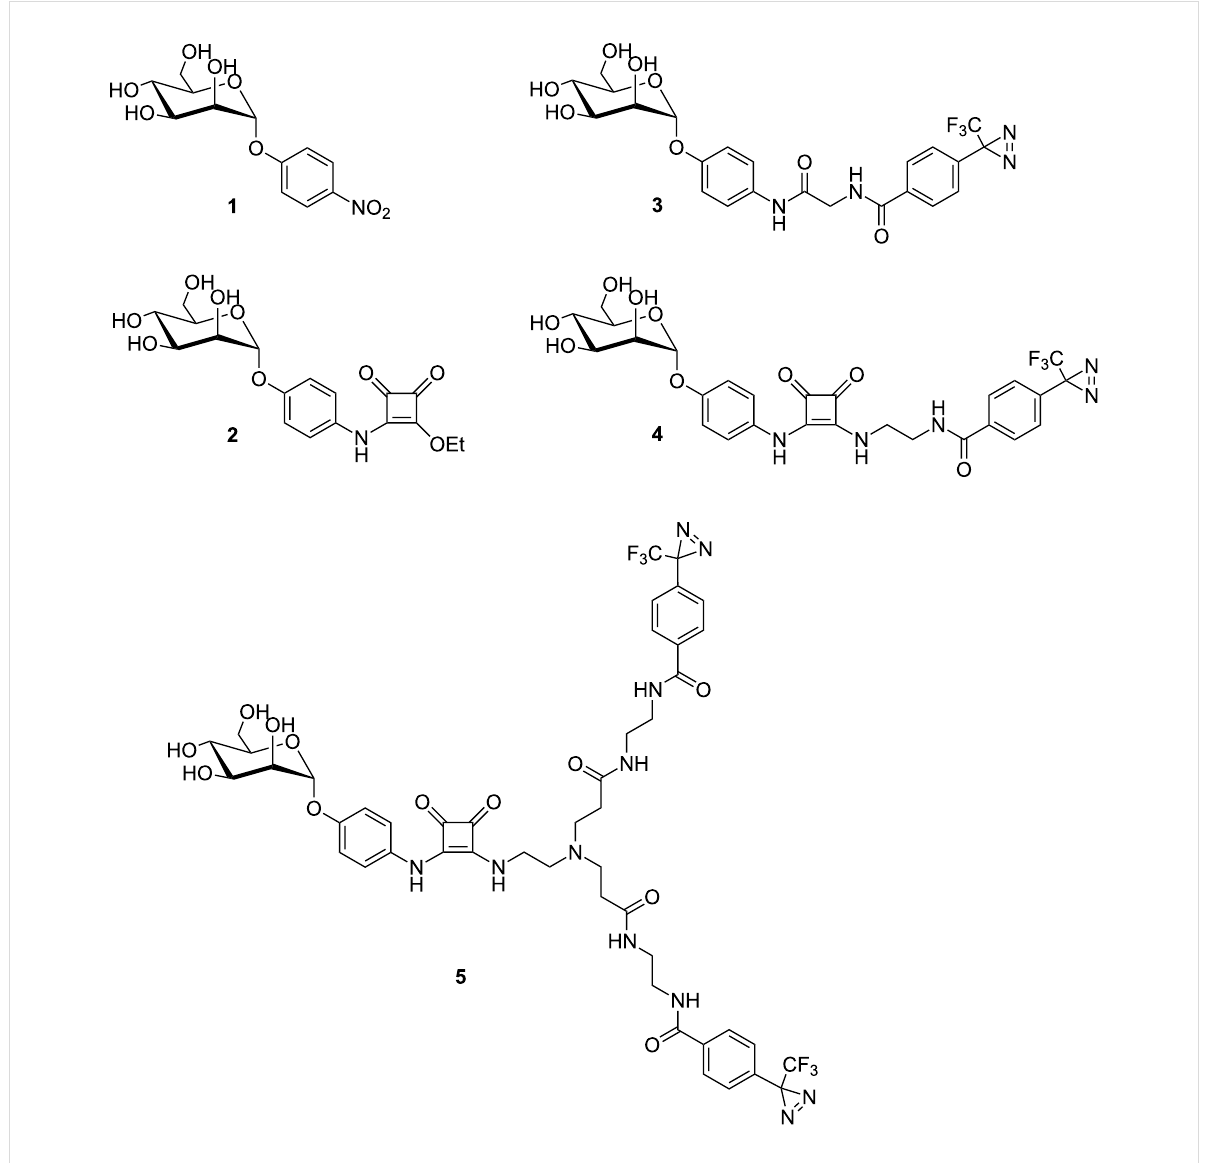
Figure 3: Based on the structure of the known FimH ligands 1 and 2 , three photolabile α -D-mannosides, 3 – 5 , were considered for FimH labeling. In 3 and 4 the distance between the diazirine functional group and the anomeric center of the mannoside are varied. In 5 a bis-diazirine functionalization is suggested to increase labeling probability.